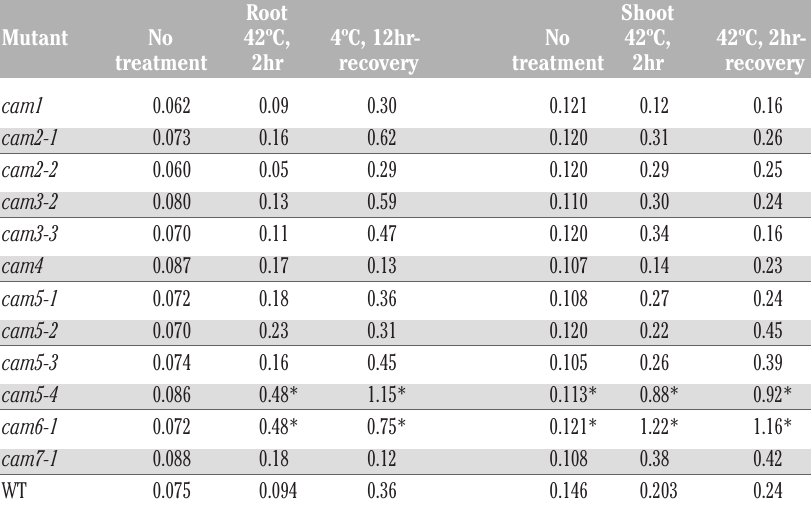
Table 4. Oxidative damage for all cam mutants under cold (42ºC, 2 hr) treatments in A.thaliana. The malonaldehyde (MDA) level was determined in root and shoot tissues by the thiobarbiturate reactive substances assay describe in materials and methods. Two set of seedlings were treated at 42ºC for 2 hours. One set was used immediately for meas- urement of MDA level, while the other set was allowed to recover for 2 days under con- tinuous light at 25°C before determination of MDA level (nmol/mg FW). Mutants with (*) represent the significant sensitivity